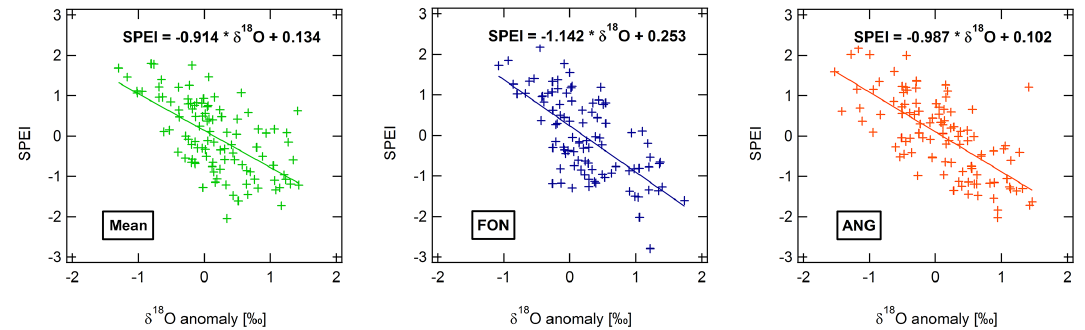
Figure 8. Linear regression between the drought index SPEI (June–August) and cellulose δ 18 O for the mean chronology, FON and ANG. The equations describing the regression line provide the models for drought reconstruction.